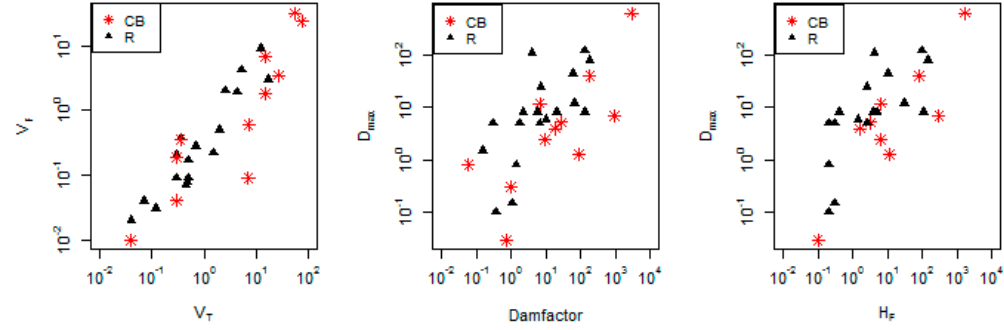
Figure 1. Left: Relationship between V F and V T in × 10 6 m 3 . Center: D max in km in relation to the dam Figure 1 Left: Relationship between V F and V T in ×10 6 m 3 . Center: D max in km in relation to the dam factor ( H × V F ). Right: D max in km in relation to H f ( H × ( V F / V T ) × V F ). All plots are in the log-log factor ( H × V F ). Right: D max in km in relation to H f ( H × ( V F /V T ) × V F ) . All plots are in the log-log scale. scale. Note that the D max vs. H f plot is much tighter than the D max vs the dam factor plot. CB are added Note that the D ma x vs H f plot is much tighter than the D max vs the dam factor plot. CB are added points points from Chambers and Bowker [15] and R are from Rico